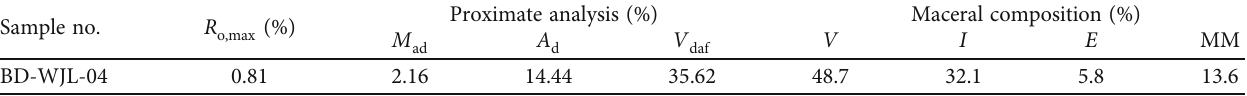
Table 1: Coal vitrinite re fl ectance, proximate analysis, and maceral composition in the Baode block. Sample